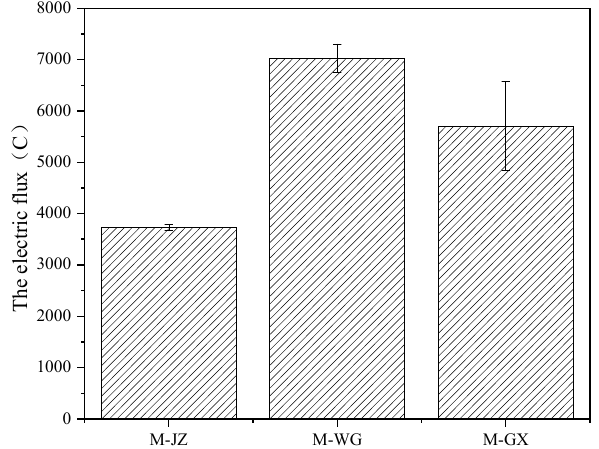
Figure 8. The electric flux of ordinary mortar (M-JZ), recycled mortar (M-WG) and modified recycled mortar (M-GX).